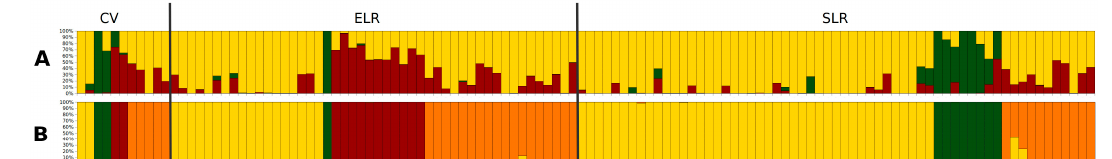
Figure 2. Population structure analysis as obtained from STRUCTURE ( A ) and DAPC ( B ) methods. ( A ) Accessions attributed to three genetic groups (yellow, green, red). ( B ) Accessions attributed to four genetic groups (yellow, green, orange, red). In both cases shown, each vertical bar indicates a single accession, which is colored according to the genetic group to which it was assigned. Accessions not assigned to a single group are colored according to the estimated proportion of membership to each genetic group and are defined as admixed. ELR, exotic landraces; SLR, Sardinian landraces; CV, modern and vintage cultivars.